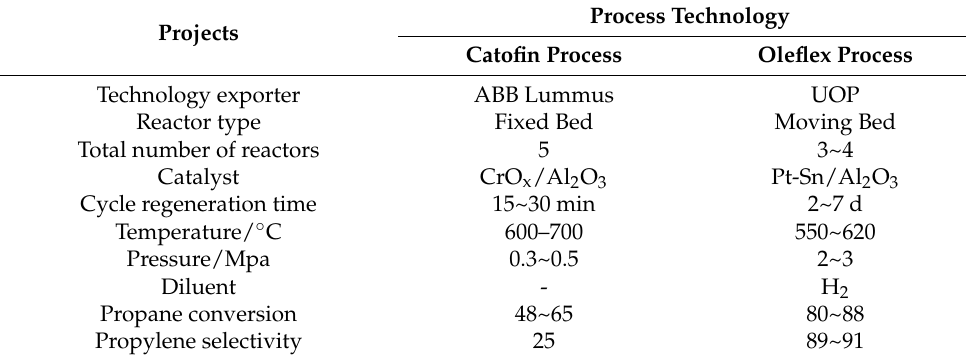
Figure 2. Process diagram of Oleflex dehydrogenation unit. Table 1. Comparison of Catofin and Oleflex propane dehydrogenation process technologies.